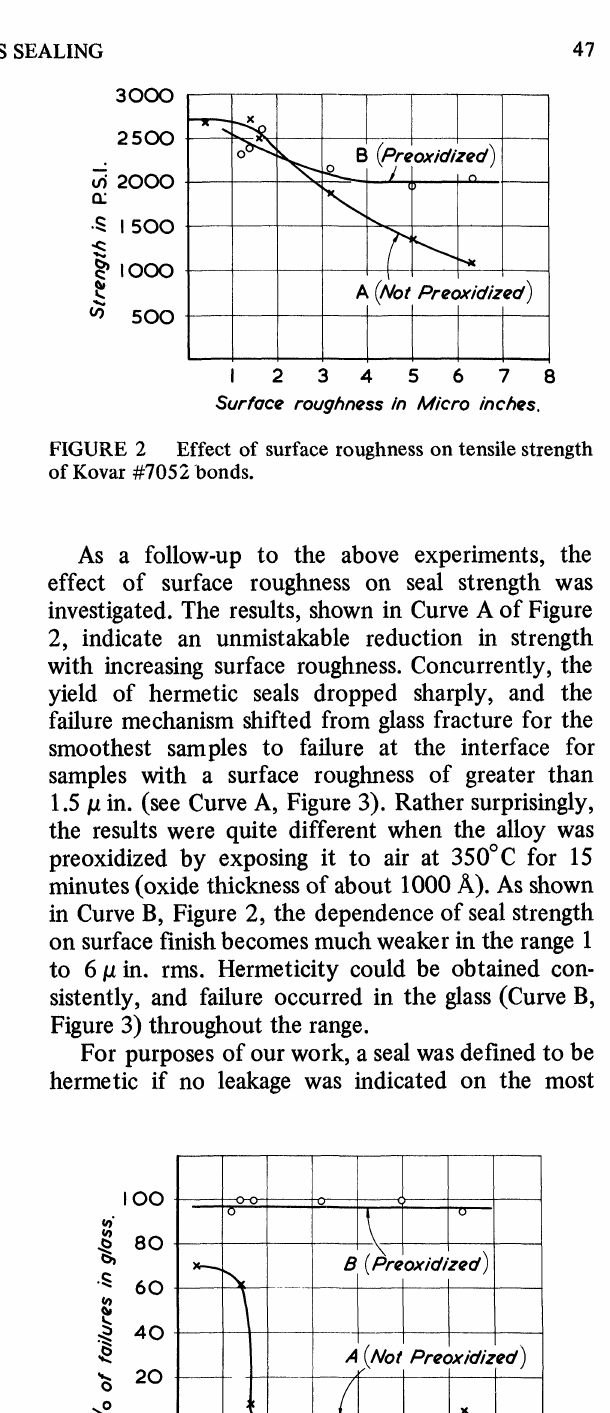
Effect of surface roughness on failure mode of Kovar # 7052